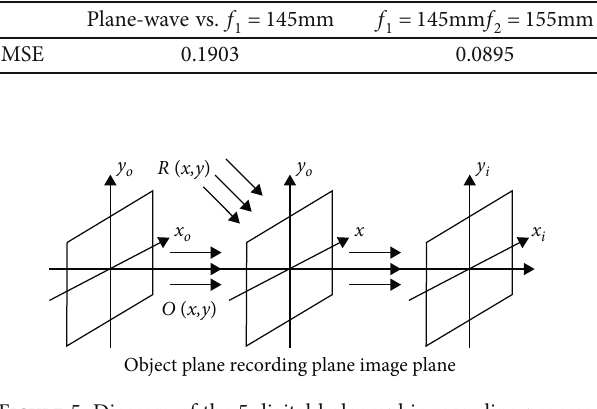
Figure 5: Diagram of the 5 digital holographic recording process.